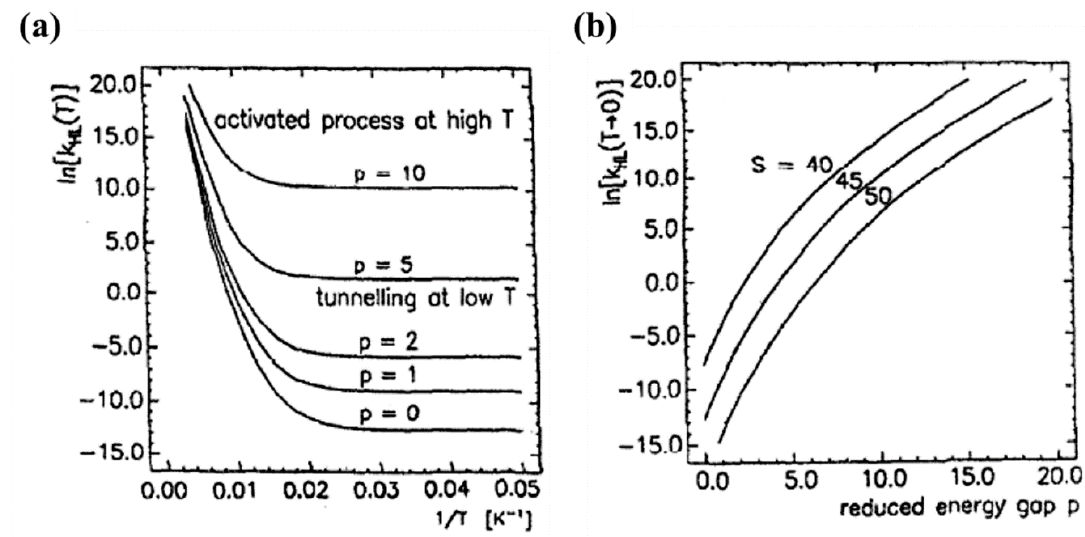
Figure 13. ( a ) The relaxation rate constant k HL in logarithmic scale as a function of 1/ T at various reduced energy gaps p , with S = 45, ¯ h ω = 250 cm − 1 and β HL = 150 cm − 1 . ( b ) The relaxation rate at T → 0 with respect to the reduced energy gap p at various S values. Reprinted with permission from Ref. [75]. Copyright 1991